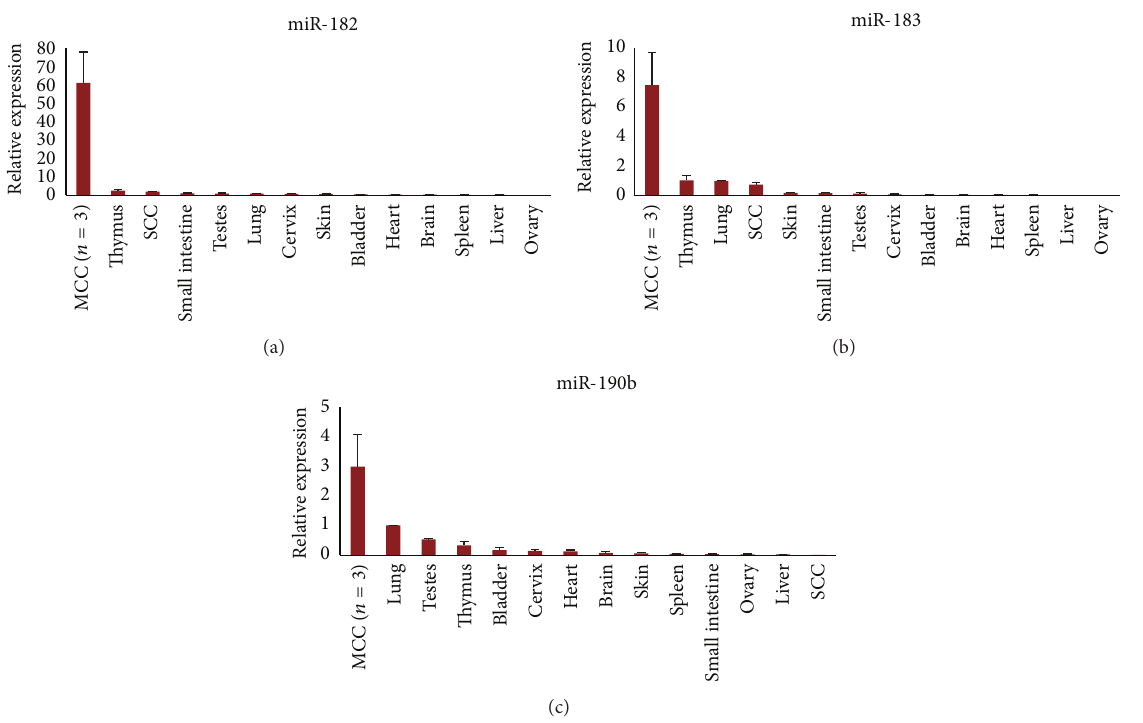
Figure 2: MCC-miRs are specific for MCC. Three MCC-miRs were confirmed via qRT-PCR to be upregulated in frozen MCC samples versus a human tissue panel consisting of twelve different body organs: miR-182, miR-183, and miR-190b. Error bars refer to SEM.